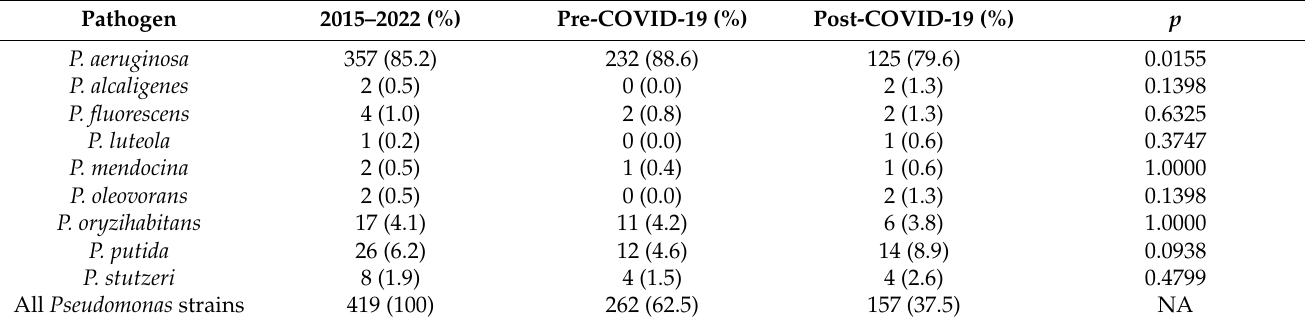
Table 2. Microbiology of Pseudomonas strains isolated from patients’ blood